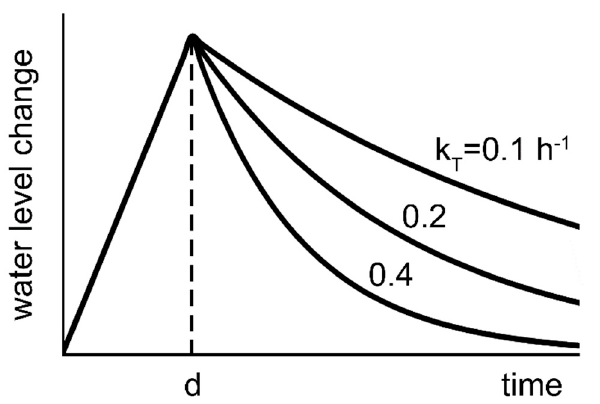
Figure 2. Example of the calculated change in the groundwater level due to rain infiltration. A slope failure occurs when